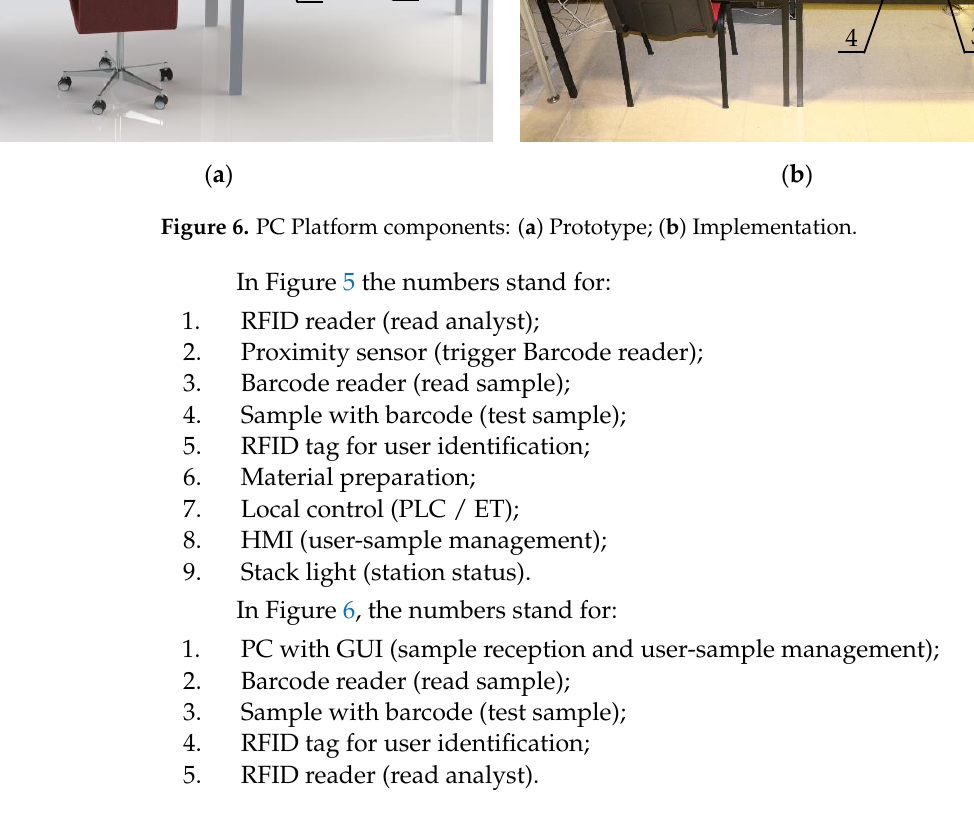
Figure 6. PC Platform components: ( a ) Prototype; ( b ) Implementation.